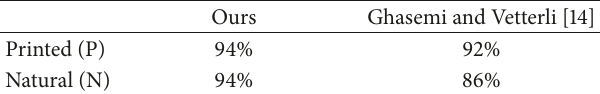
Table 1: The detection accuracy